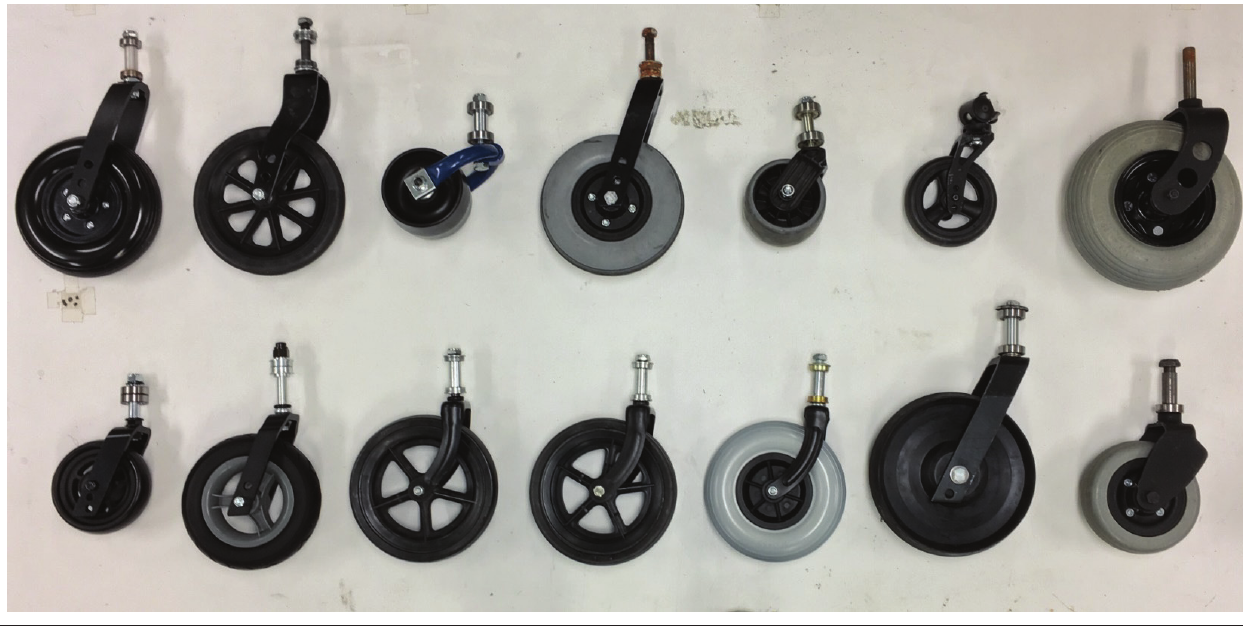
FIGURE 1: Different caster designs used on